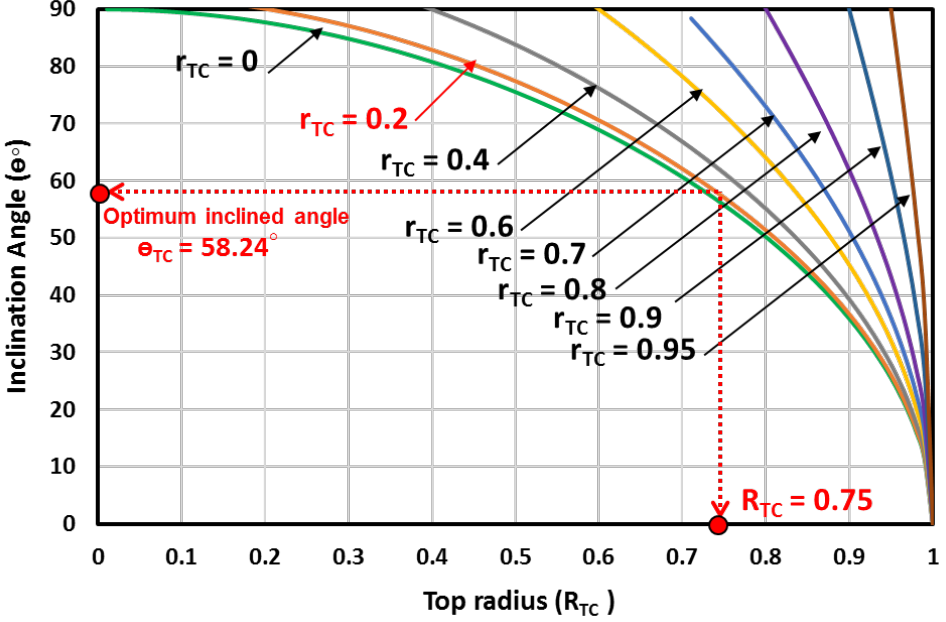
Figure 7. The inclination angle against the top radius and the bottom radius.